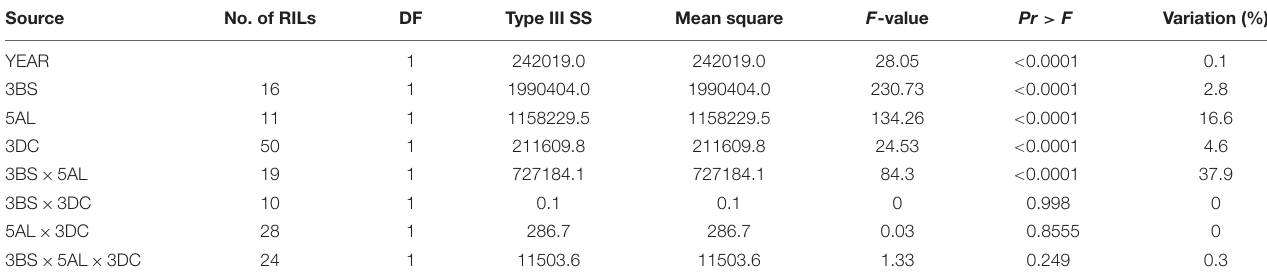
TABLE 4 | Three-way factorial analysis of variance (ANOVA) of area under disease progress curve (AUDPC) for stripe rust resistance loci, using years as blocks.